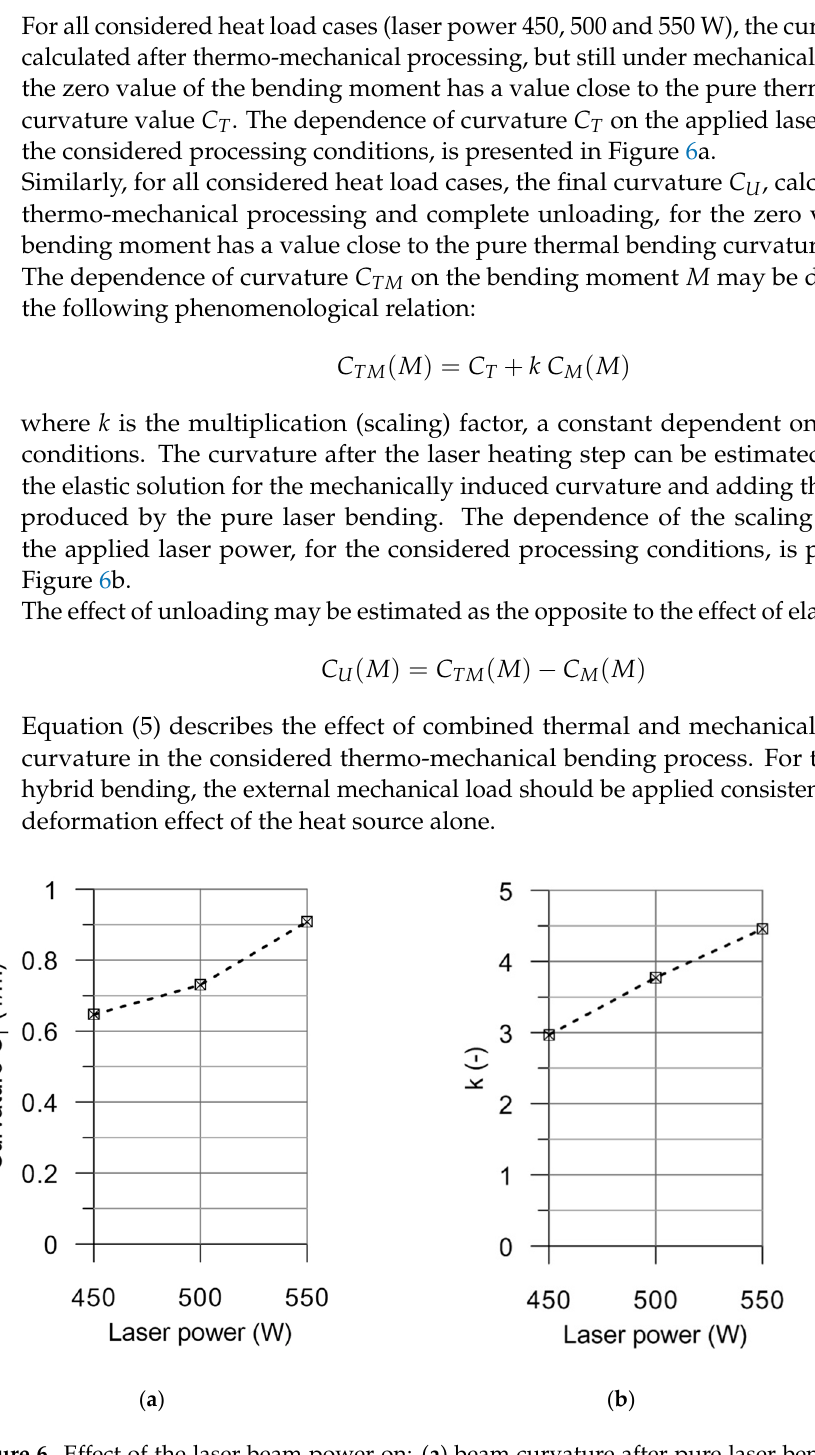
Figure 6. Effect of the laser beam power on: ( a ) beam curvature after pure laser bending C T and ( b ) the multiplication factor k (free-end load force F = 3.04 N).